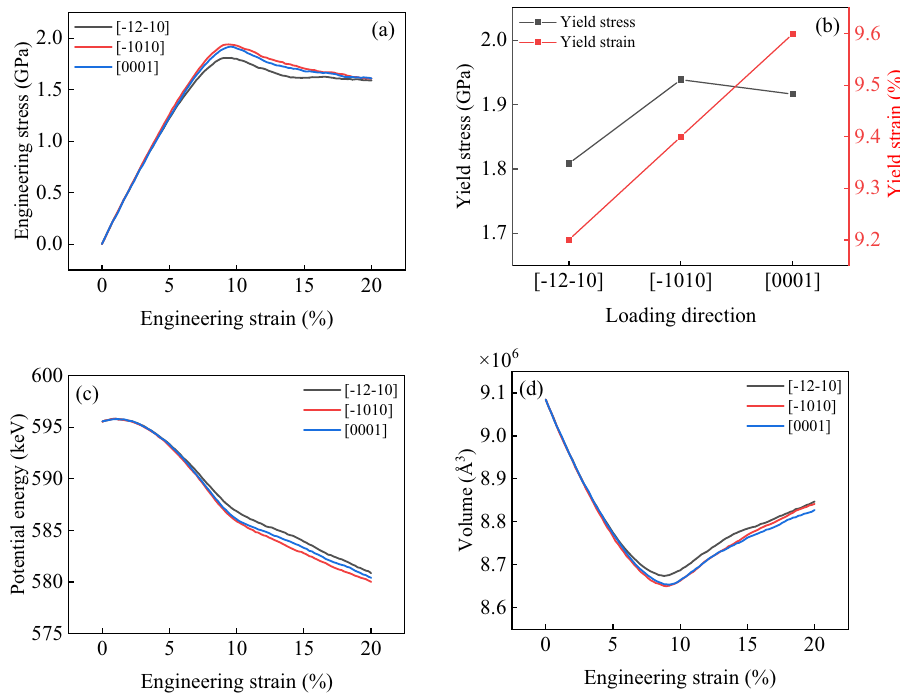
Figure 5. Performance curve. ( a ) Engineering stress–engineering strain curve; ( b ) yield stress–yield strain curve; ( c ) potential energy curve; ( d ) volume